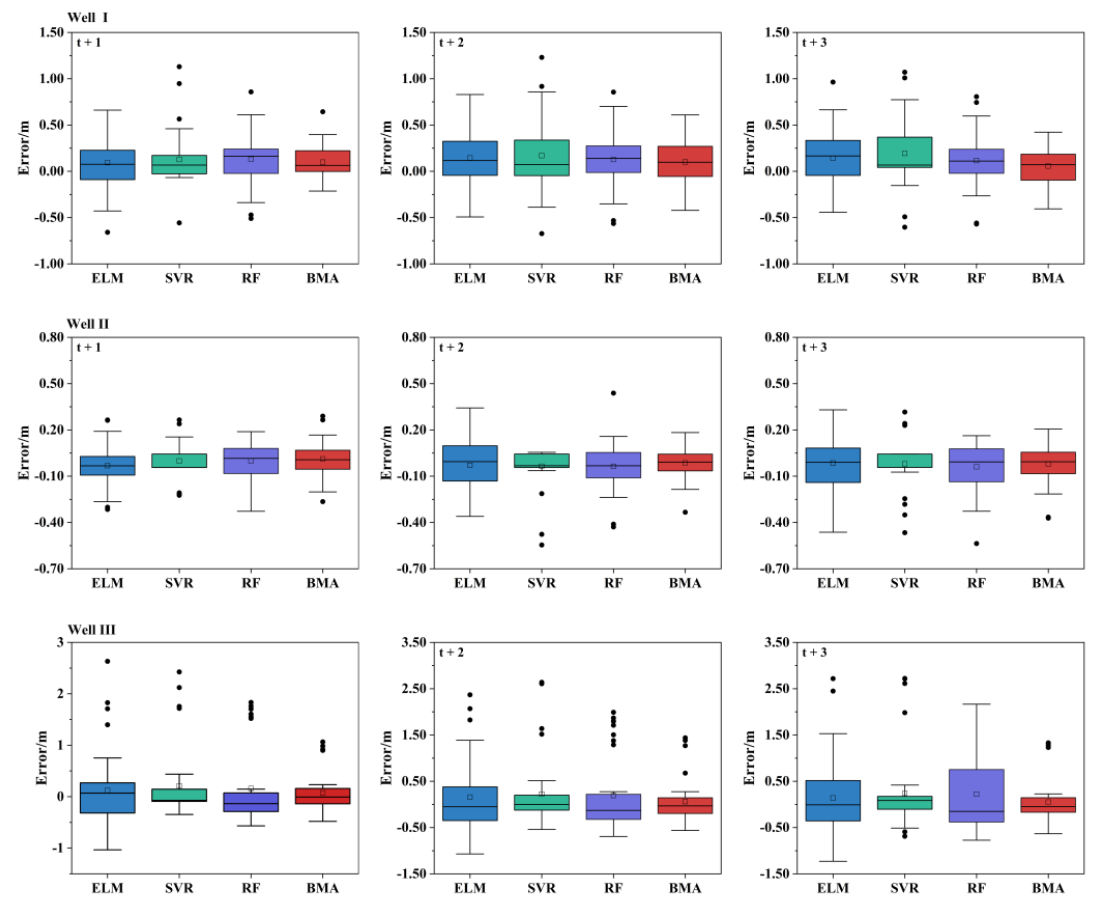
Figure 5. Error distribution boxplot of the predicted GWL obtained by the ELM, SVR, RF, and BMA models for Wells I, II, and III at 1-, 2-, and 3-month-ahead prediction horizons in the testing period. The lower and the upper end of the boxplot present the 25th and 75th percentiles, respectively; the line and the small square inside the box present the median and average, respectively; and the outliers outside the box denote the values >1.5 interquartile (the black dot).